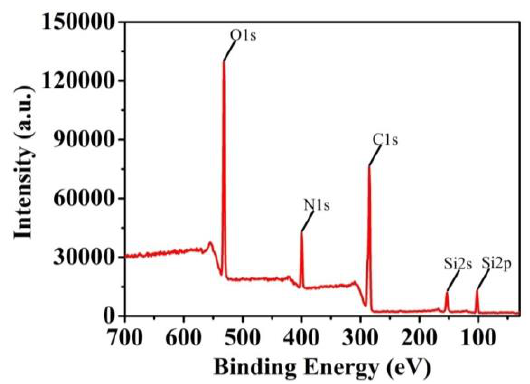
Figure 4. XPS of the cyogel F.